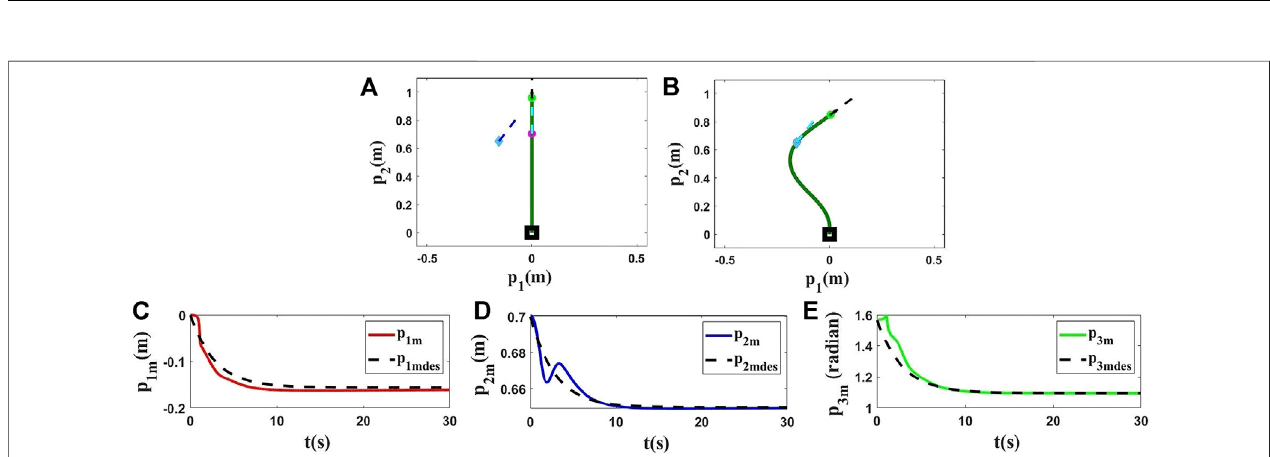
FIGURE6| Simulation 4.Firstrow: (A) and (B) aretheinitialand fi nalshapeoftheobject,respectively.Thedesiredstateofthepoint m isshown asabluediamond (position) and a dashed line segment (orientation). L = 1.00( m ), M 0 = [0.0000, 0.7000, 1.5708] T , and M fdes = [ − 0.1564, 0.6495, 1.0952] T . After applying the proposed controller to this model, the fi nal state of the controlled point is [ − 0.1563, 0.6536, 1.0952] T . Second row: (C) , (D) and (E) are the states of the controlled point based on the desired trajectories in the fourth simulation using the ARAP model.